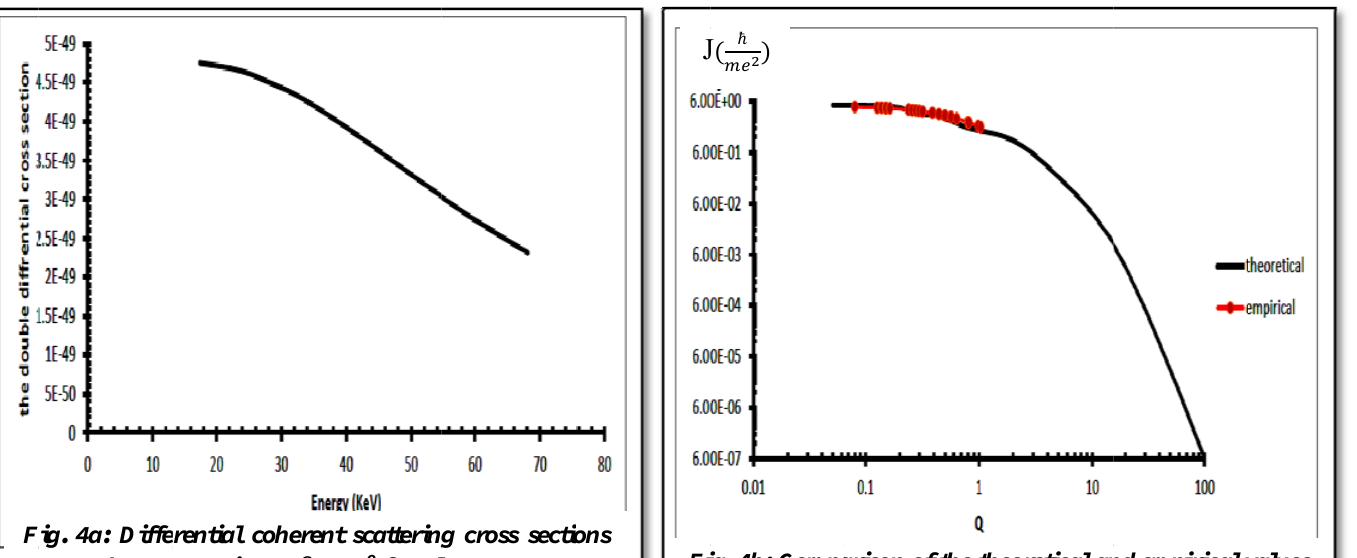
Coig. 4b: Compa r Compton values for